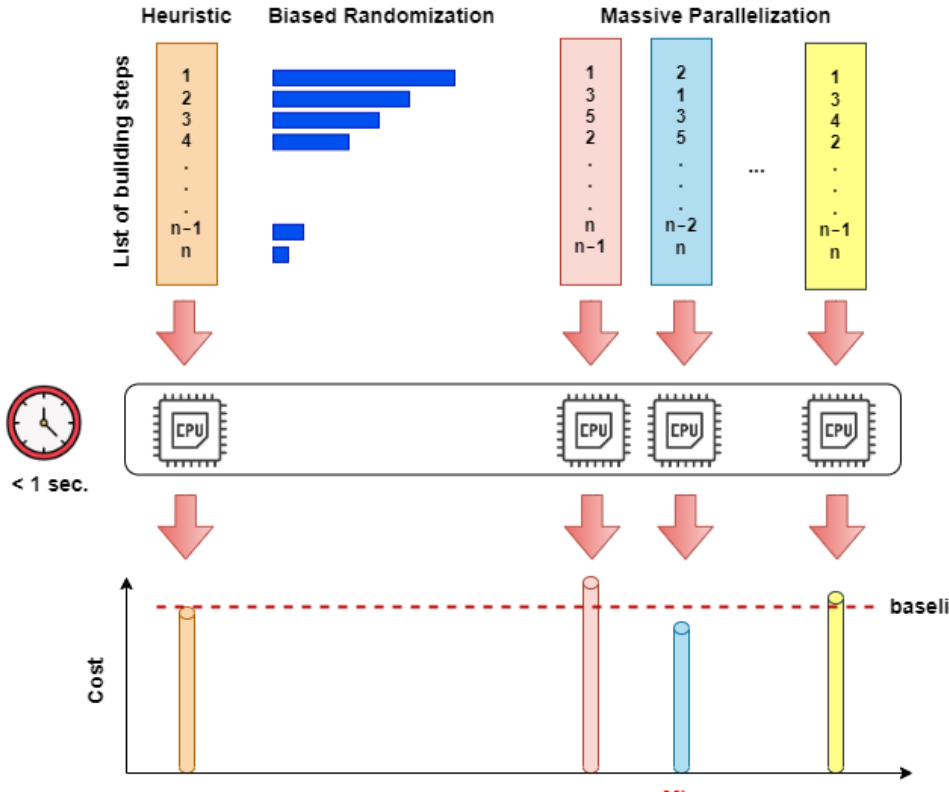
Figure 4. Illustrating the concept of